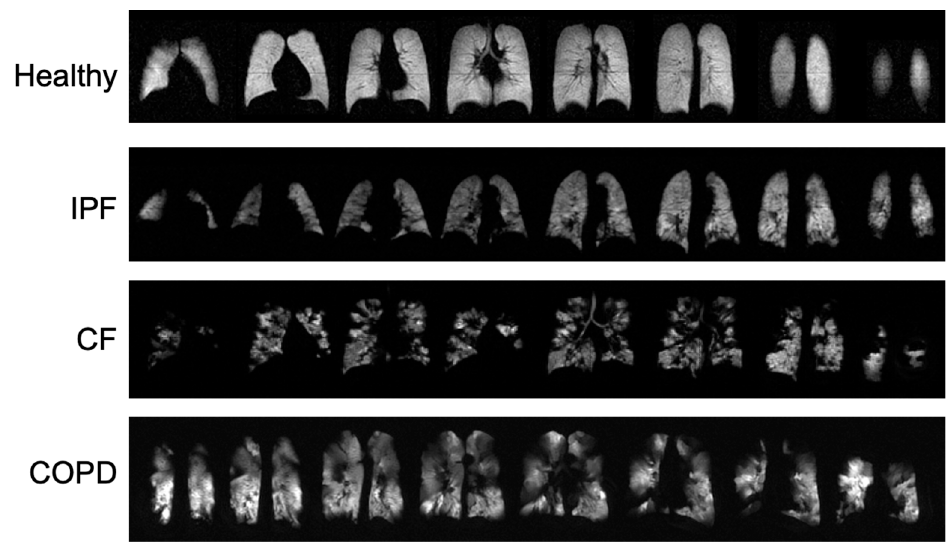
Figure 1. Ventilation images from a healthy subject and each disease type. Bright, homogeneous areas show that the lungs are ventilating normally.